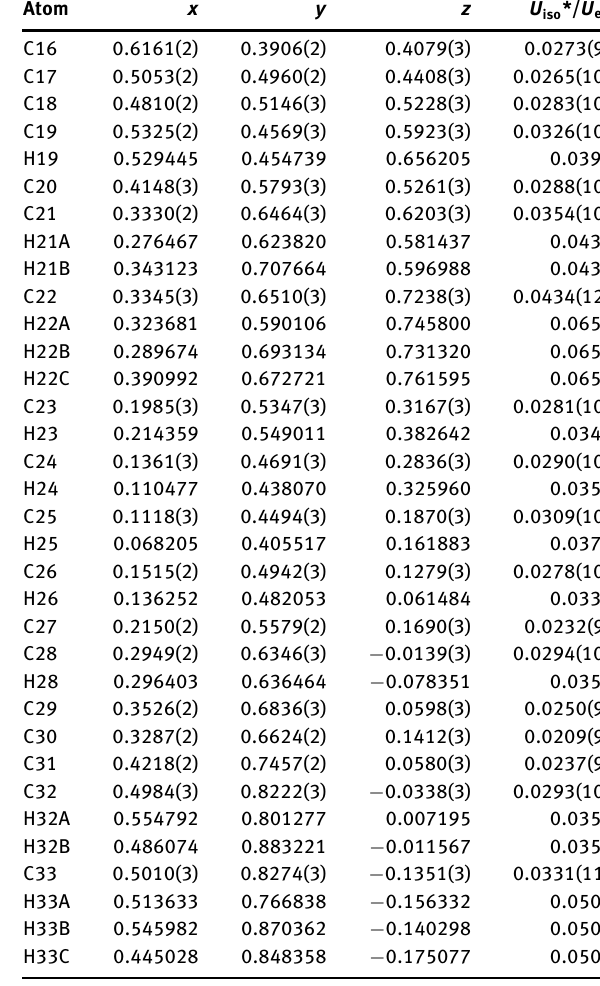
Table 2: Fractional atomic coordinates and isotropic or equivalent isotropic displacement parameters (Å 2